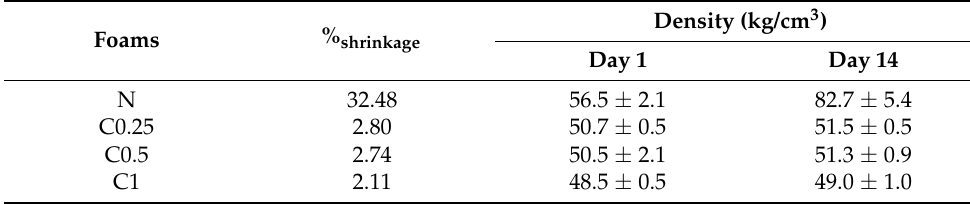
Table 2. The collapse behavior assessment of PU foams.